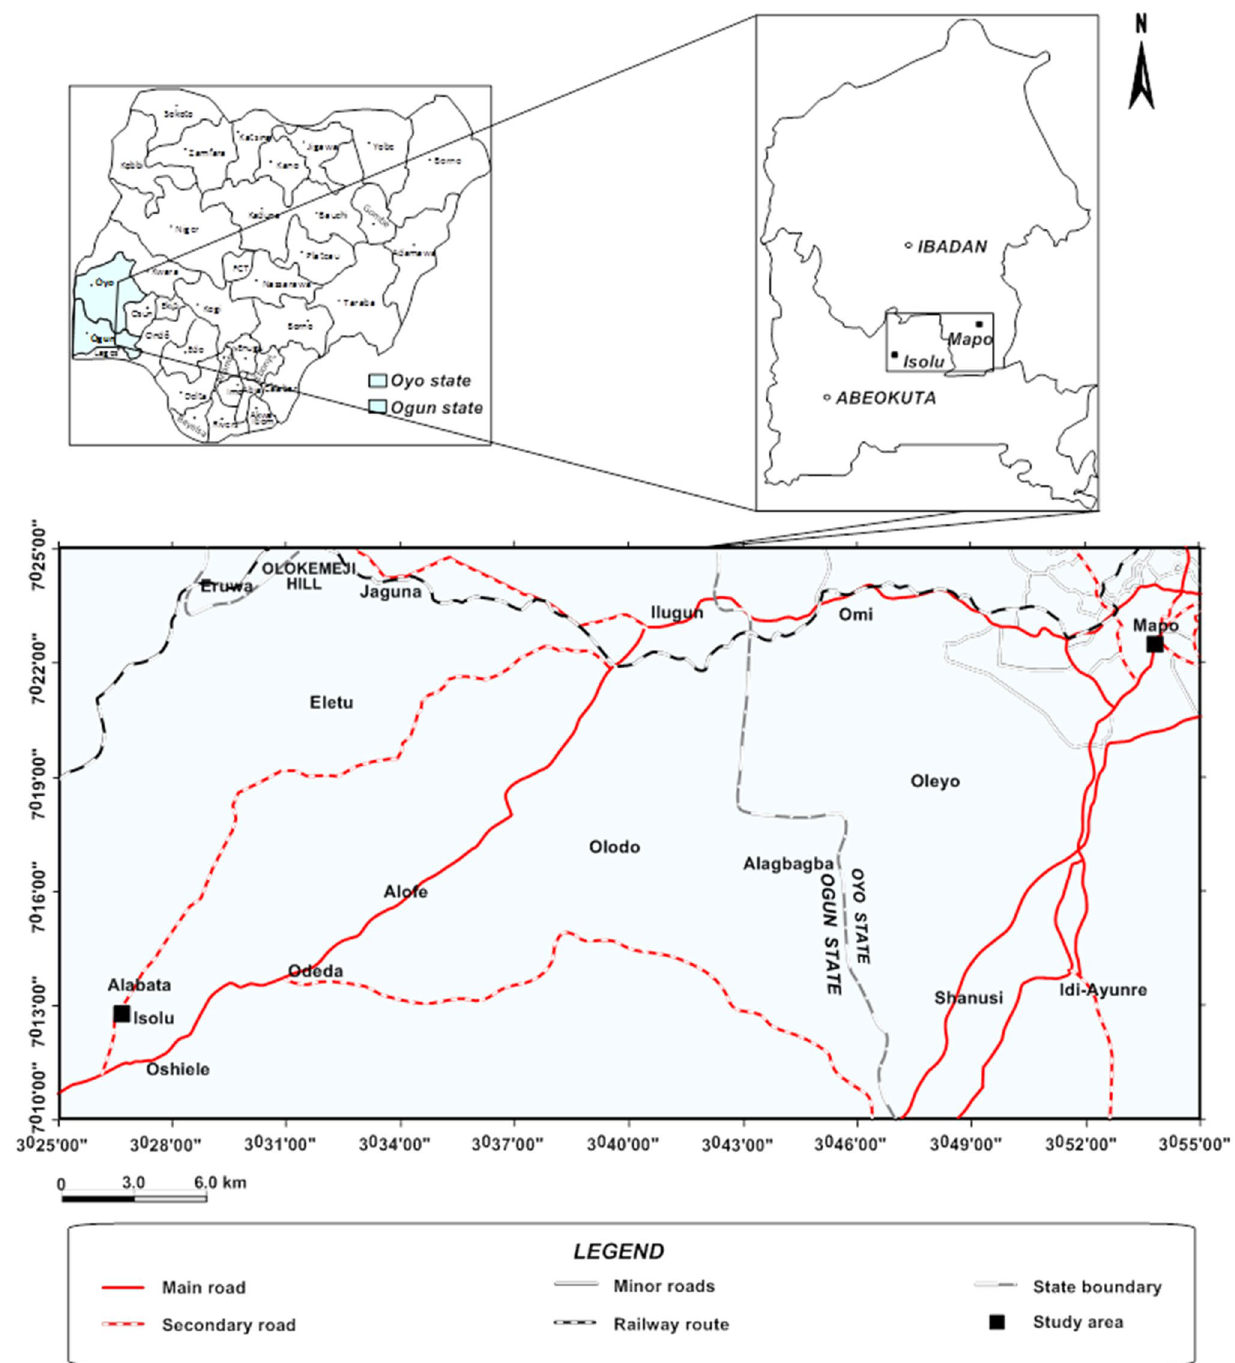
Fig. 1 Location map of the study area